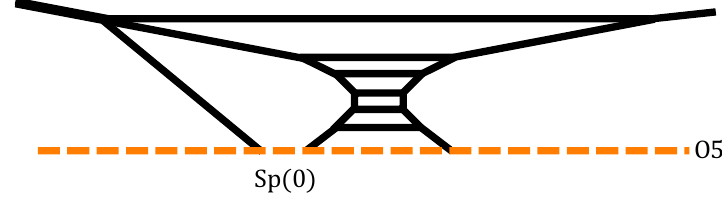
Figure 1 . A 5-brane diagram which realizes the SO(12) gauge theory with a half-hypermultiplet in the conjugate spinor representation. In the left upper conner, two 5-branes of the charge ( (cid:0) 3 ; 1) should be understood as they are bound by a single 7-brane of the same charge ( (cid:0) 3 ; 1), respecting the